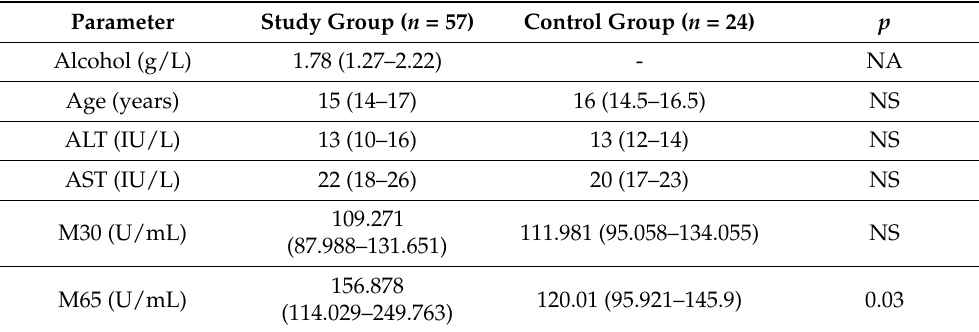
Table 1. Characteristics of the study and control groups: alanine aminotransferase (ALT), aspartate aminotransferase (AST), not significant (NS), not applicable (NA).